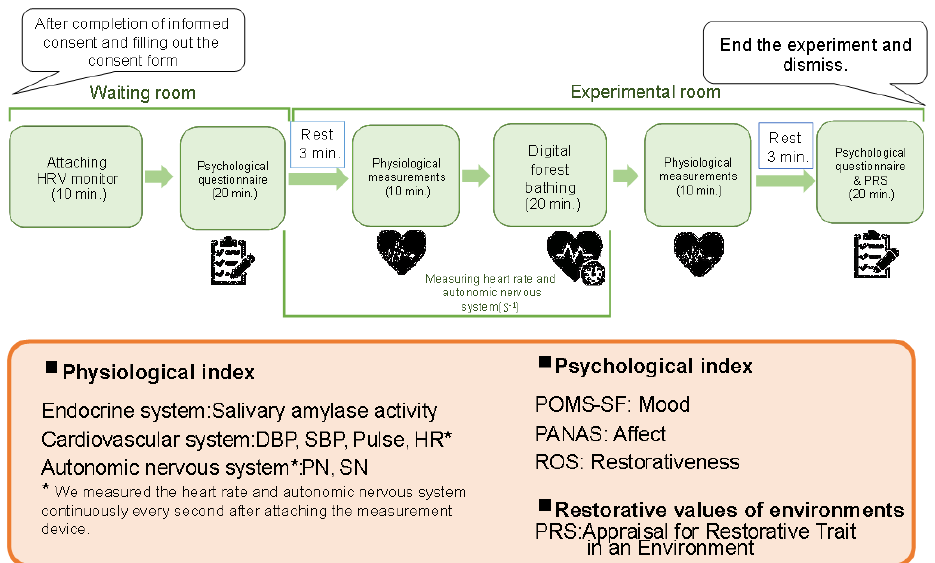
Figure 4. Experimental protocols and indicators.